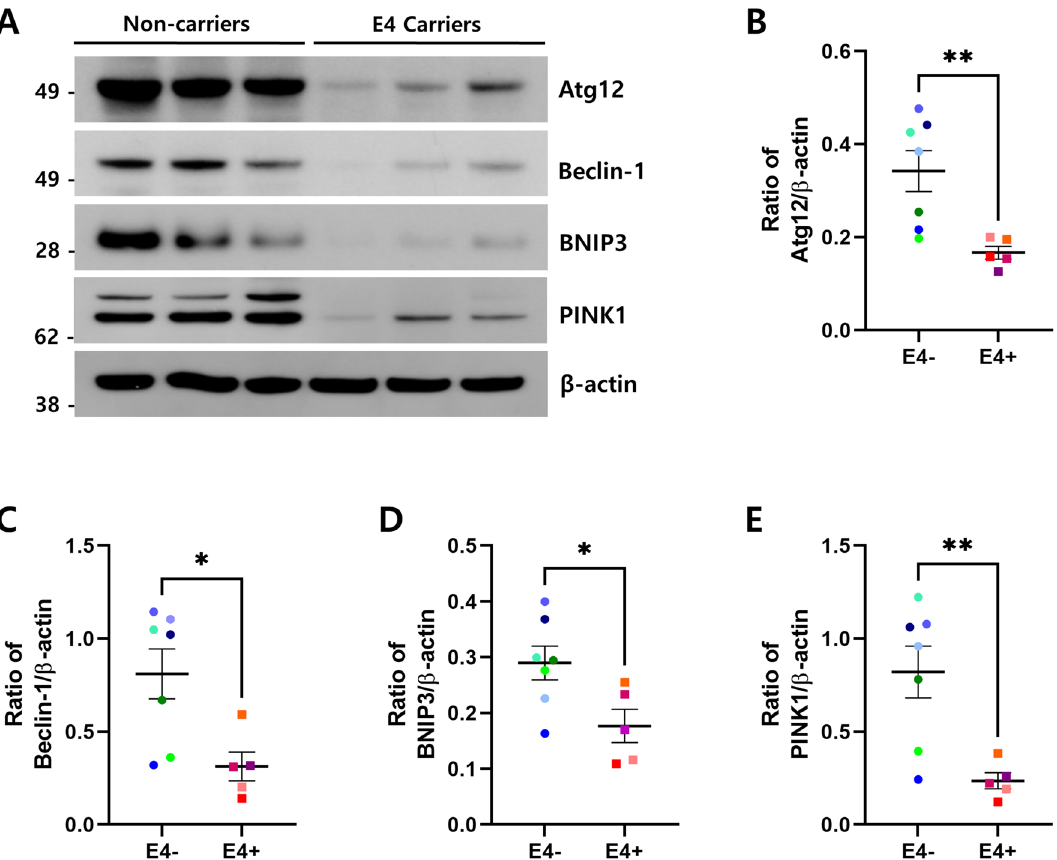
Figure 2. Protein levels of FoxO3a downstream genes decreased in ApoE4 carriers. The protein levels of Atg12, Beclin-1, BNIP3, PINK1, and β-actin in ApoE4 non-carriers (n = 7, E4−) vs. carriers (n = 5, E4 +) were analyzed by immunoblotting using the corresponding antibodies, respectively. ( A ) shows the representative western blot analysis of Atg12, Beclin-1, BNIP3, and PINK1. β-actin was used as a loading control. Full blots are provided in Supplementary Fig. S4. Relative ratio of Atg12 ( B ), Beclin-1 ( C ), BNIP3 ( D ) and PINK1 ( E ) against the protein level of β-actin. Data shown are mean ± SEM and were analyzed using the Student’s t-test. (* p < 0.05, ** p <